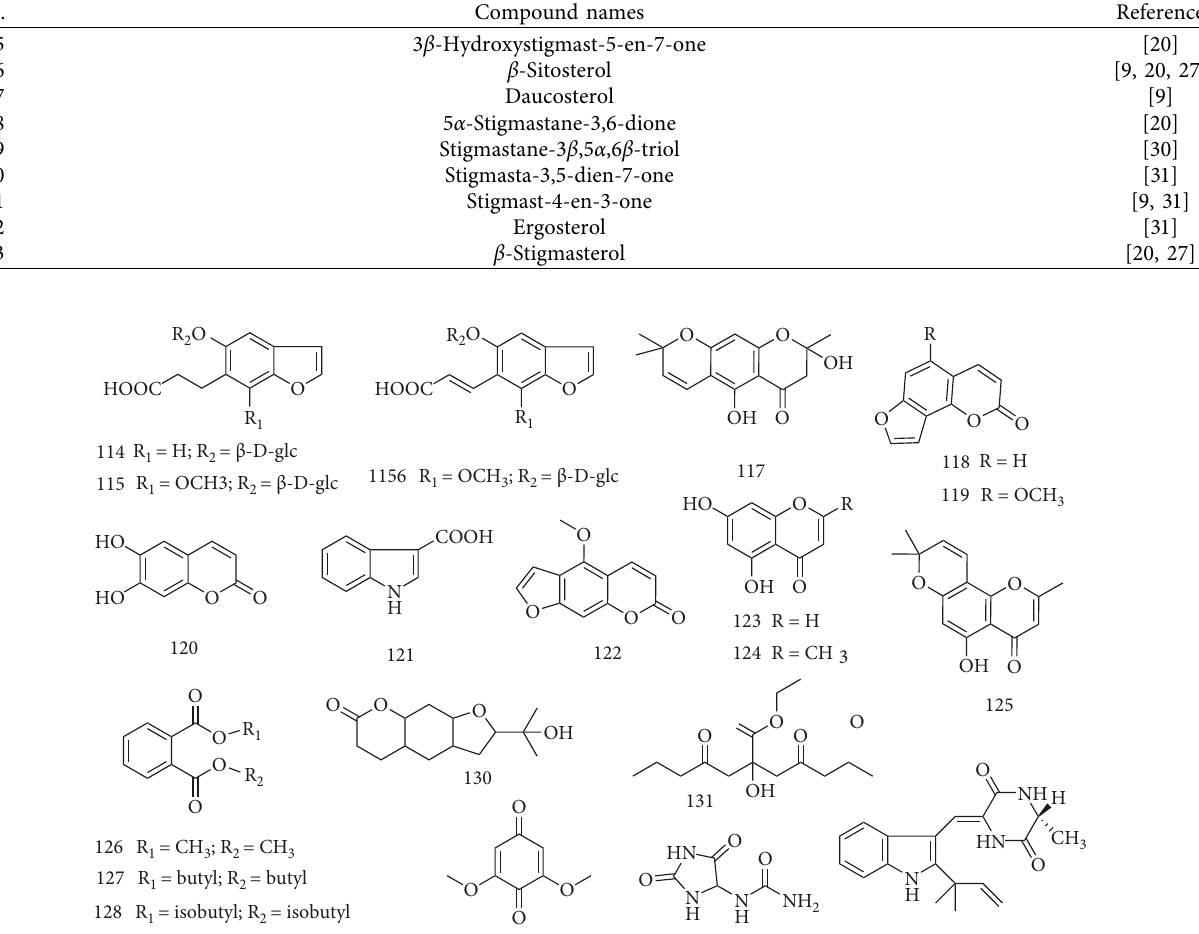
Table 4: Steroids isolated from F. tikoua Bur.